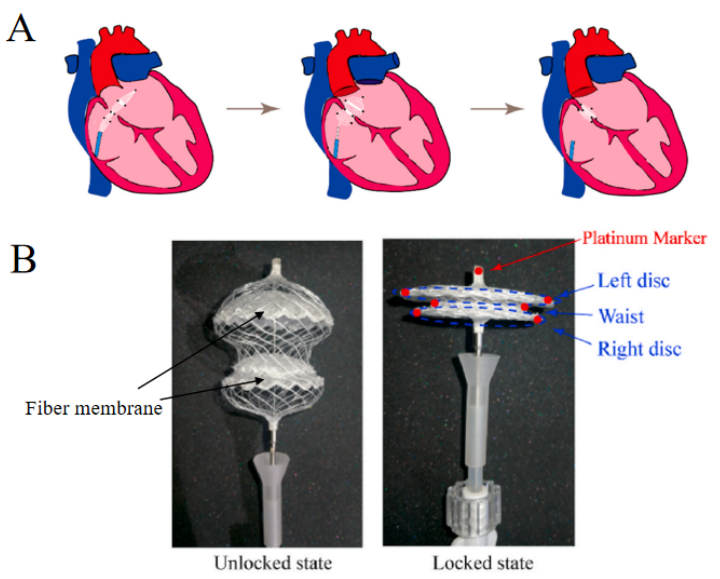
Figure 1. Preparation of a biodegradable ASD occluder ( A ) and photos of ASD in different states ( B